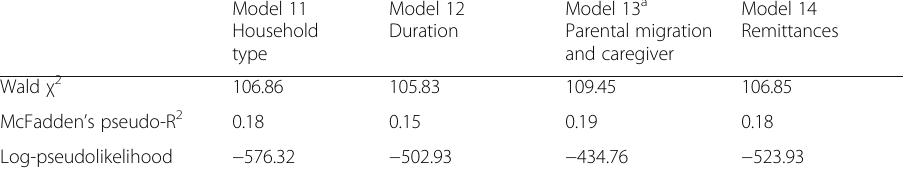
Table 4 Different transnational family characteristics and children ’ s health: Georgia